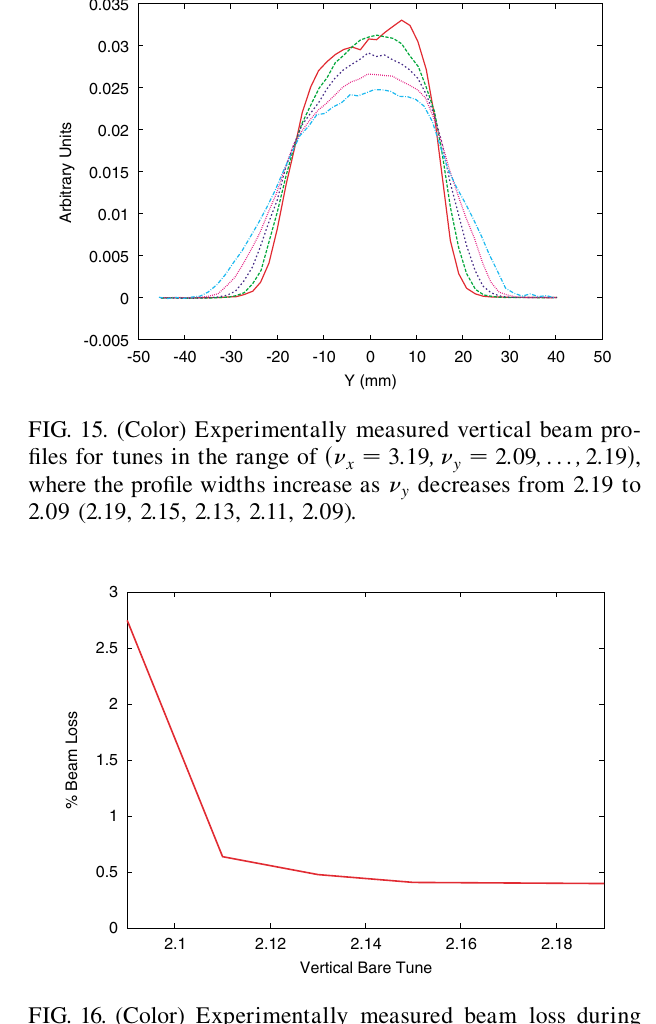
FIG. 16. (Color) Experimentally measured beam loss during accumulation versus vertical bare